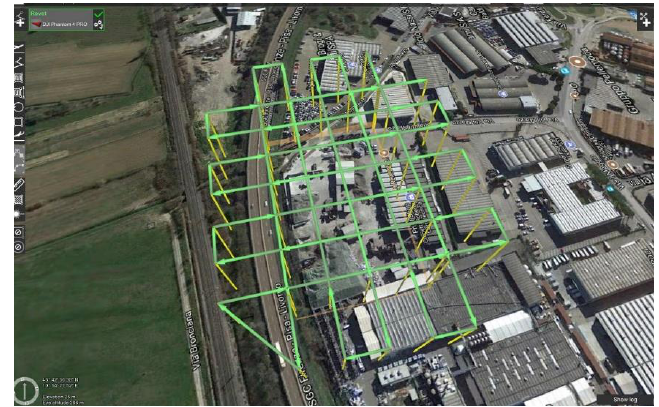
Figure 12. Flight plan used for the three flights.